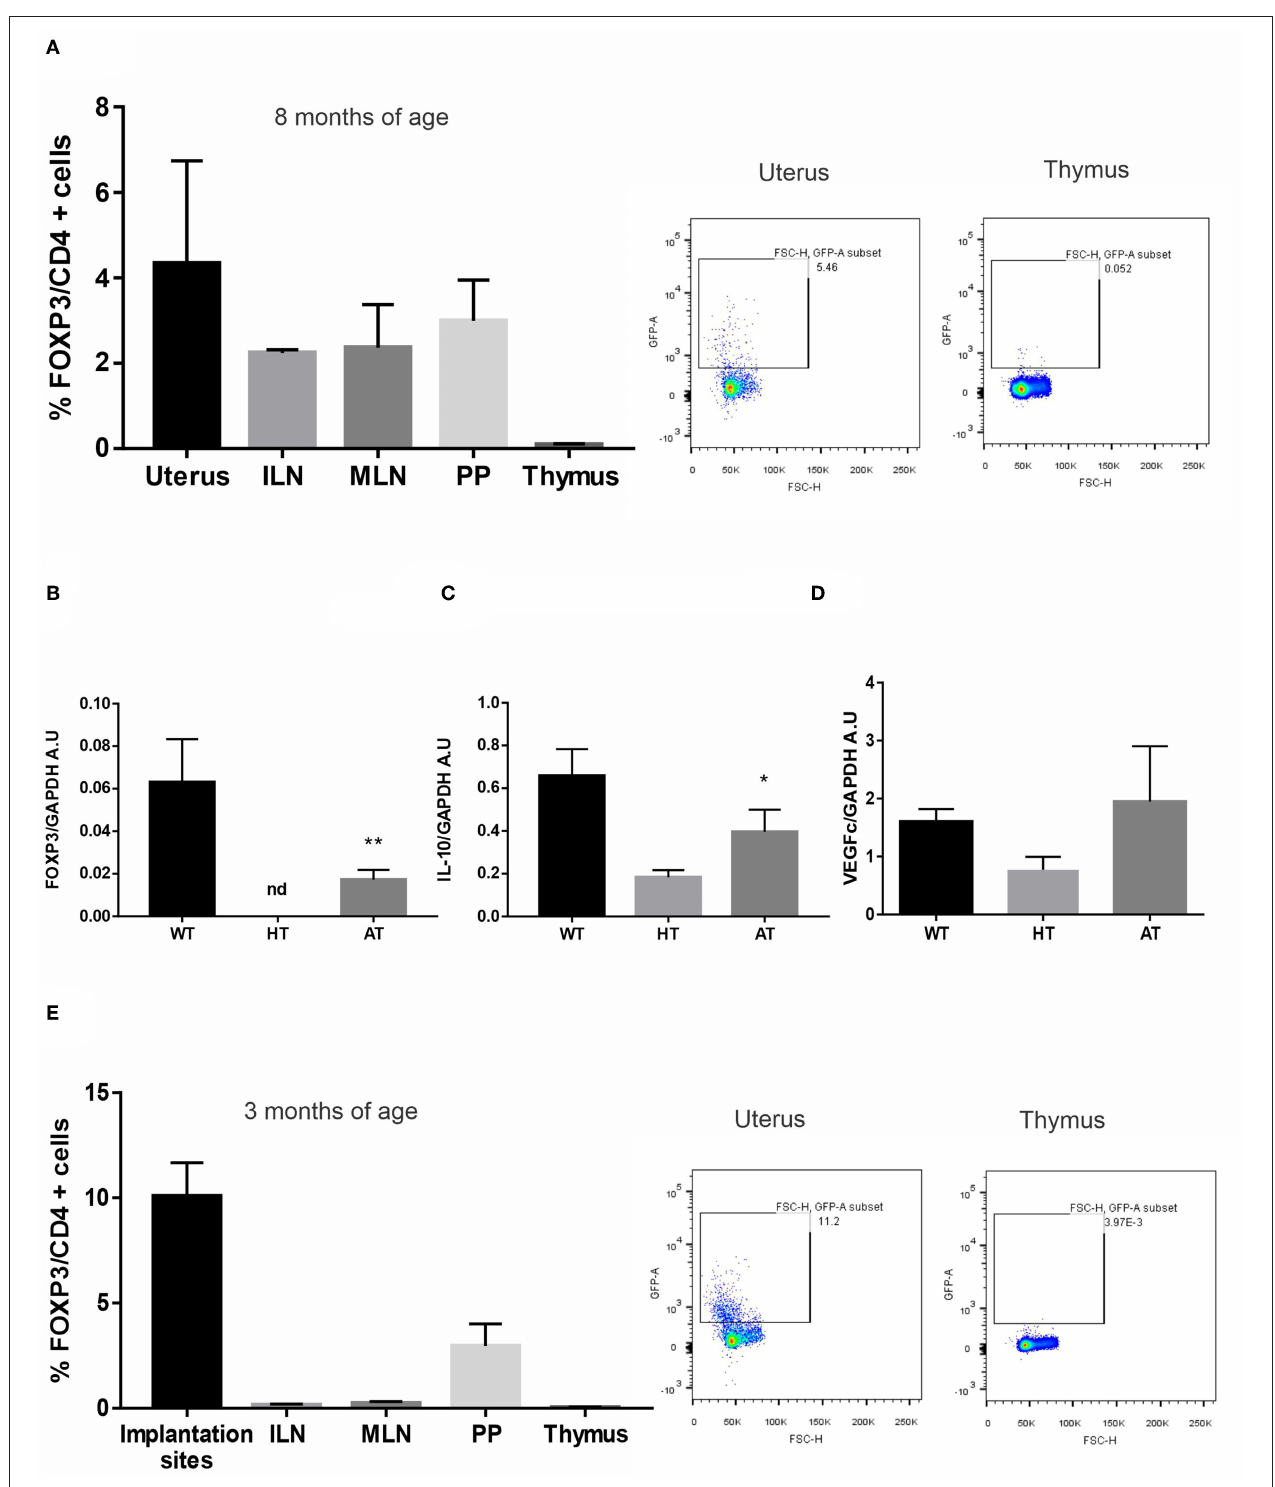
FIGURE 6 | The adoptive transfer (AT)of regulatory T cells (Tregs) improves implantation site microenvironment in vasoactive intestinal peptide (VIP)-deficient mice. Tregs, FOXP3-GFP cells, were sorted from inguinal (ILN) and mesenteric lymph nodes (MLN) from FOXP3-GFP-knock-in females and were transferred to VIP heterozygous (HT) that have not gotten pregnant in 6 months. Then, they were mated with WT males, and after vaginal plug was observed, they were sacrificed at d5.5. (A) CD4 + FOXP3 + cells frequency in uterus, ILN, MLN, Peyer patches (PP), and thymus. Results are expressed as mean % CD4FOXP3 + cells ± SEM of